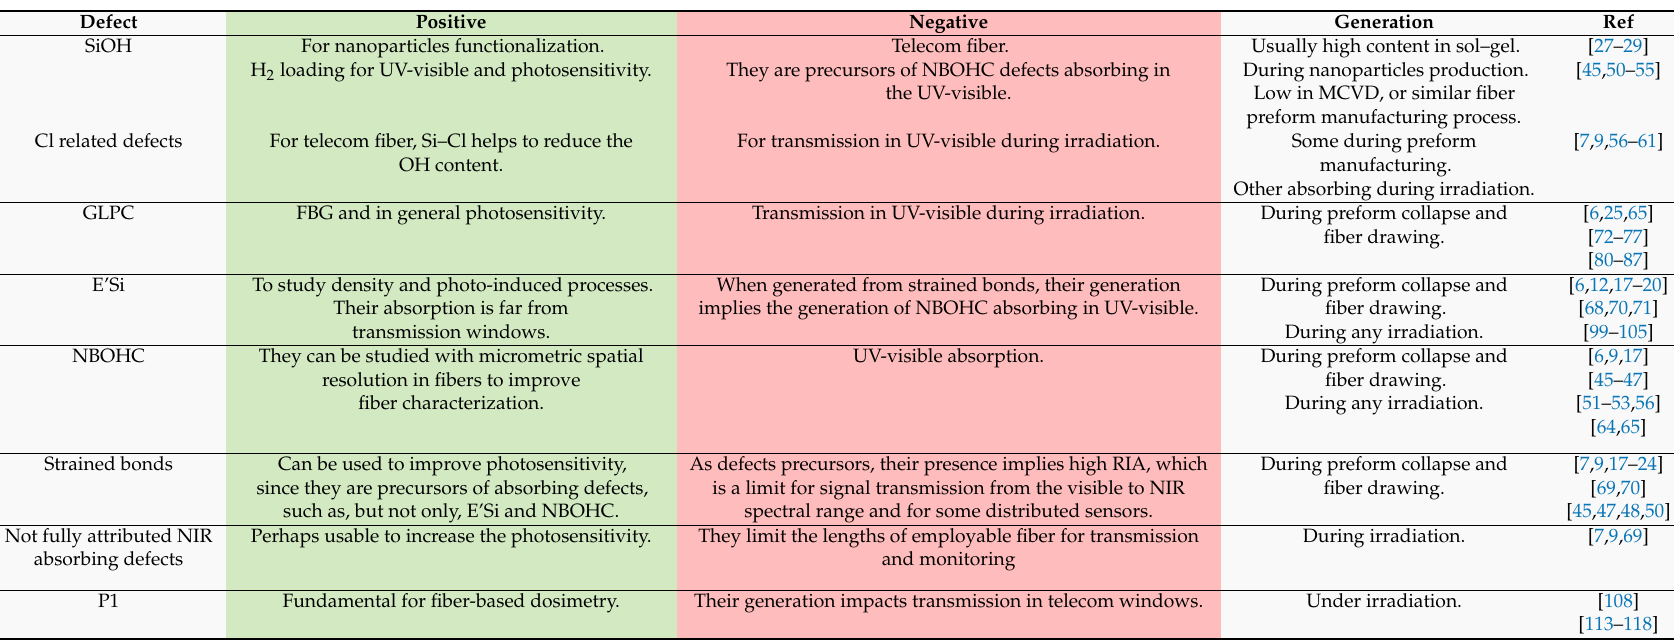
Table 1. Defect name, positive and negative e ff ects on silica properties / application and a process that normally implies their generation. MCVD: modified chemical vapor